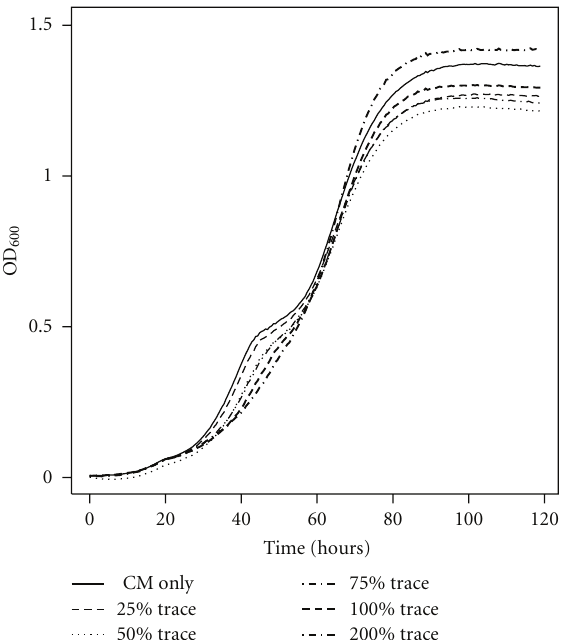
Figure 7: Influence of trace element concentration on the growth curve of Halobacterium salinarum NRC-1. Halobacterium salinarum NRC-1 was grown in CM with 0X, 0.25X, 0.5X, 0.75X, 1.0X and 2.0X standard Fe 2+ and Mn 2+ concentrations (18 µ M and 1.9 µ M) in a 96-well plate as described in Materials and Methods. Growth was tracked by OD 600 and reported against the y-axis in linear scale to highlight phenotypic di ff erences. OD 600 values were converted to a path length of 1cm to be equivalent with other optical density measurements in this manuscript. Each curve is an average of six